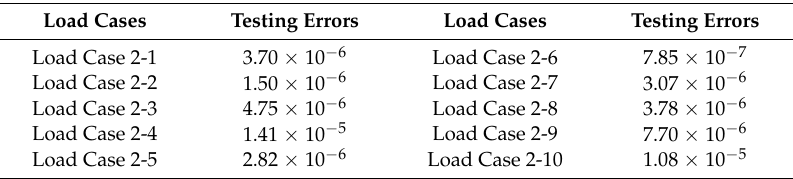
Table 7. Testing errors (MSE) of Load Case 2-1 to 2-8.